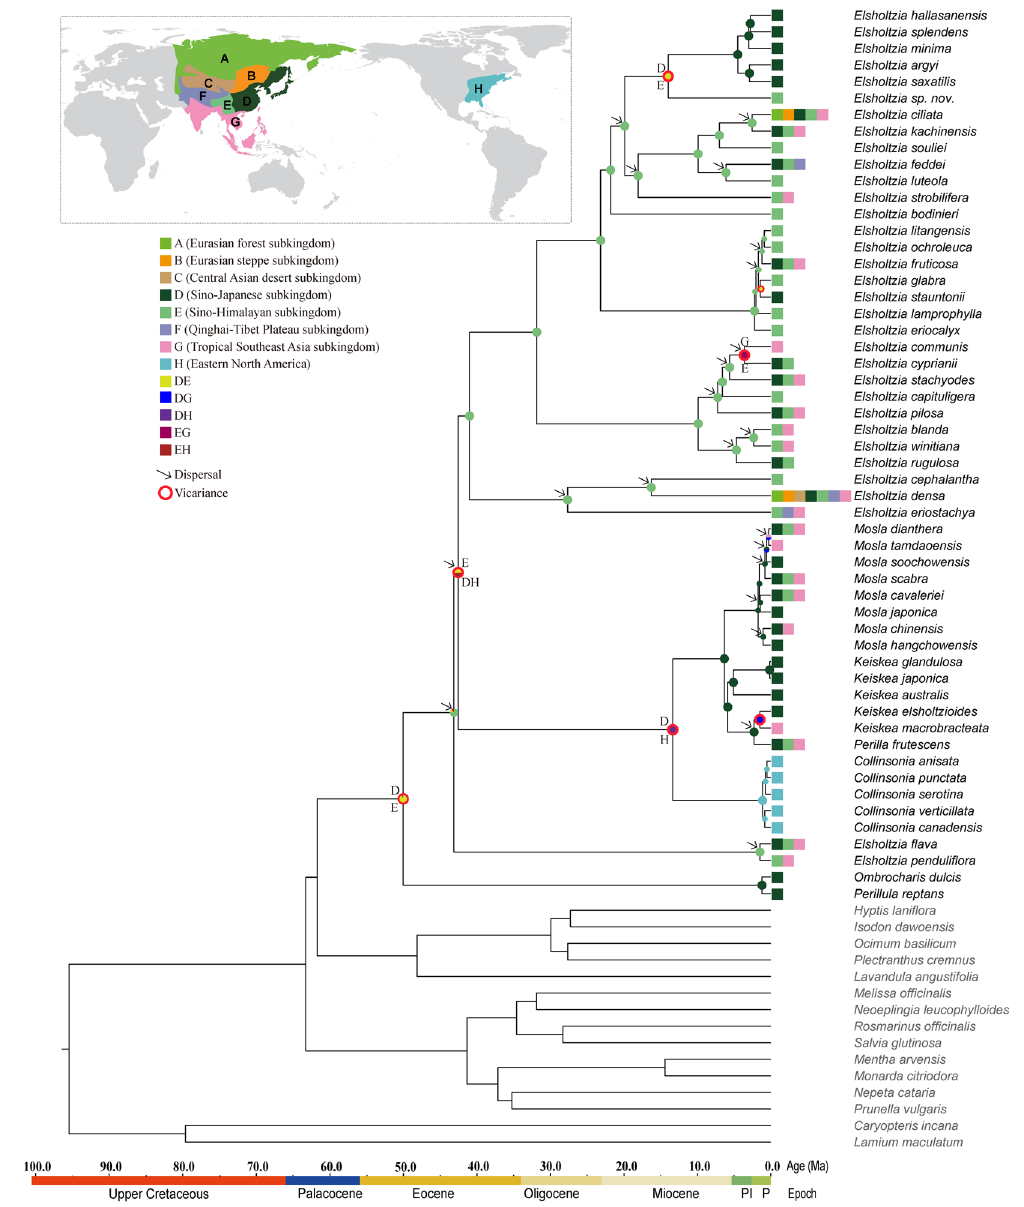
Figure 3. Ancestral area reconstruction of Elsholtzieae as inferred with Statistical Dispersal-Vicariance Analysis (S-DIVA) in rasp, using 1,000 random Bayesian trees from the beast analysis. Nodal probabilities of ancestral areas are depicted on the Bayesian tree of Fig. 2. Single-colored pie diagrams indicate an ancestor confined to a single geographic area; multi-colored pie diagrams represent the probabilities of different areas at each node. Arrows and circles represent dispersal and vicariance events, respectively. The base map was freely downloaded from Wikimedia Commons online (https://commons.wikimedia.org/wiki/File:BlankMap- Equirectangular.svg), with subsequent